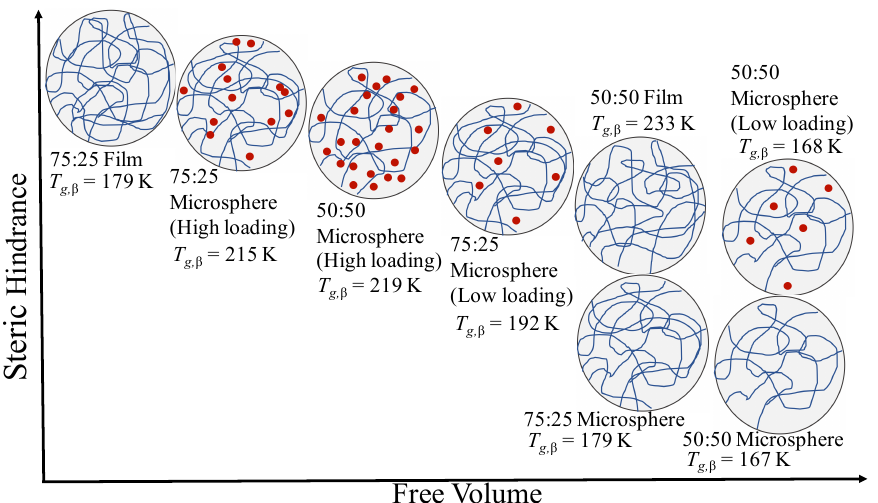
Figure 6. Behavior of the different materials with increasing steric hinderance and free volume. Blue lines represent the PLGA copolymer (20–30 kDa MW), and solid red circles represent the exendin-4 molecules (4.2 kDa MW). Low loading and high loading refers to 1 mg/mL and 10 mg/mL of polypeptide loaded in PLGA microspheres, respectively. With an increase in free volume and decrease in steric hinderance, the values of T g, β is decreased.